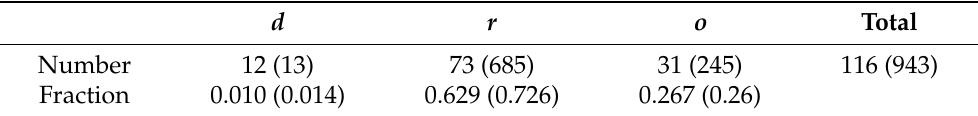
Table 3. Additionally predicted loci in comparison to current annotation for human (hg38). Reported numbers of families overlapping with each respective annotation category and the number of loci from this families in parenthesis. d : different miRNA, r : repeat and o : other non-intergenic region. Numbers were reported keeping a hierarchical comparison to avoid intersections between sets as: d > r > o